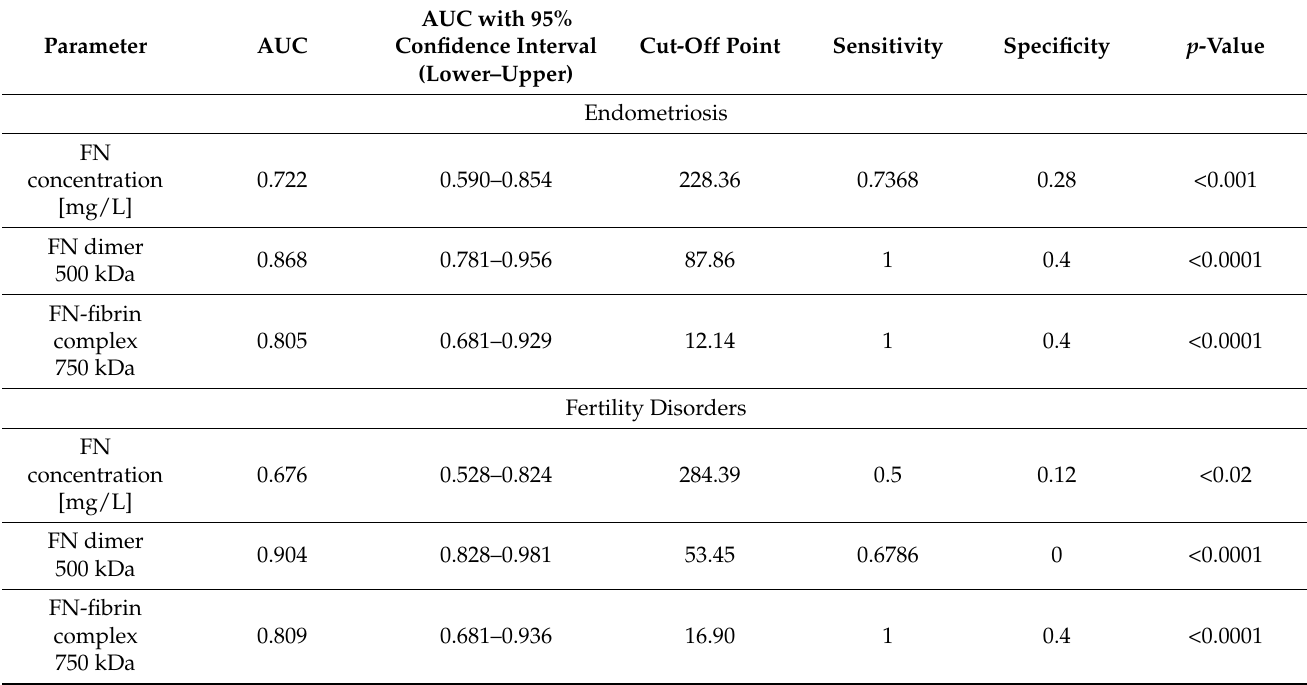
Table 3. Receiver operating characteristic (ROC) curves for plasma FN concentration and relative amount of dimer (500 kDa) and FN-fibrin complex 750 kDa as potential predictors of endometriosis and fertility disorders. AUC with 95% Parameter AUC Confidence Interval Cut-Off Point Sensitivity Specificity p (Lower–Upper)